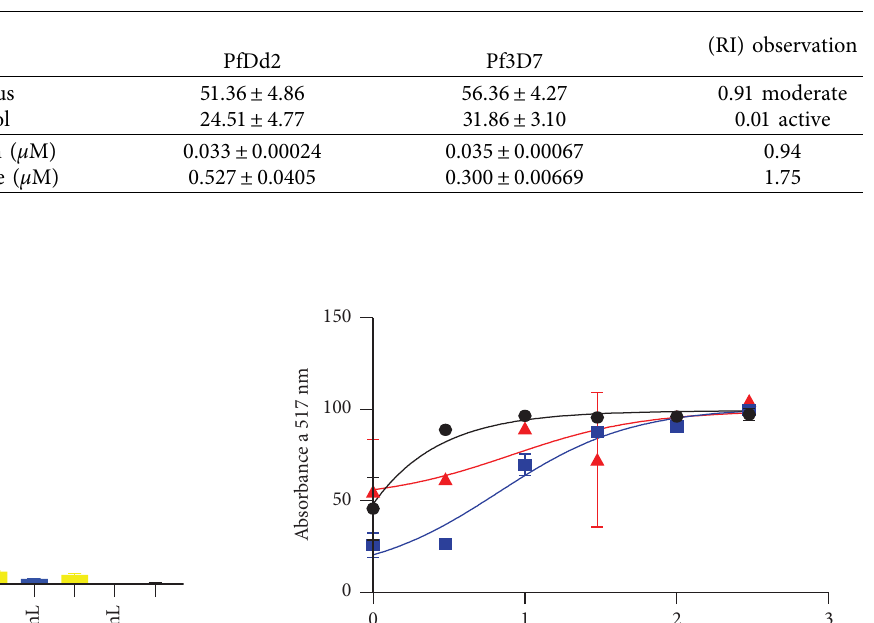
Table 1: In vitro antiplasmodial activity.